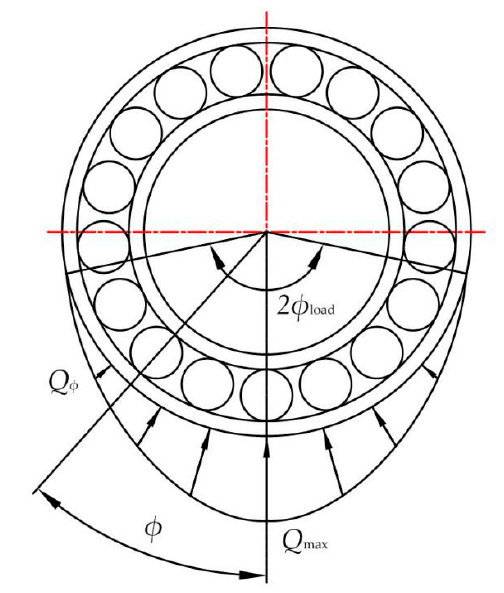
Figure 1. Load distribution diagram of outer ring during bearing operation.